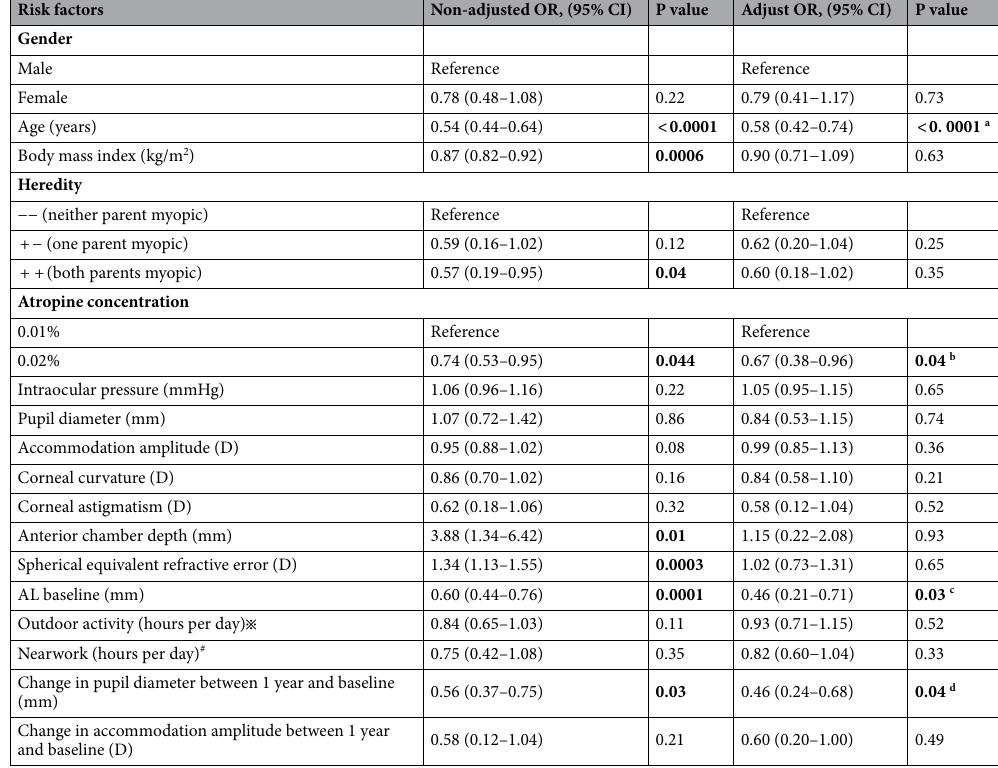
Table 2. Univariate and multivariate logistic regression analyses showing risk factors associated with rapid axial length elongation over 12 months. The bold represents P value less than 0.05. Note: # due to: Spherical equivalent refractive error > -1.25D (N = 8) or <—6.0D (N = 2), astigmatism ≤—2.0D (N = 3), intraocular pressure > 21 mmHg (N = 2), had cataract surgery (N = 1). OR odds ratio; CI confidence interval. a Adjusted: body mass index (BMI), spherical equivalent refractive error (SER), accommodation amplitude (AMP), anterior chamber depth (ACD), outdoor activity and nearwork. b Adjusted: age, parental myopia status, SER, AMP, corneal curvature, ACD and nearwork. c Adjusted: gender, age, BMI, SER, AMP, corneal curvature, ACD, outdoor activity and nearwork. d Adjusted: age, BMI, SER, AMP, pupil diameter, corneal curvature, ACD and nearwork.